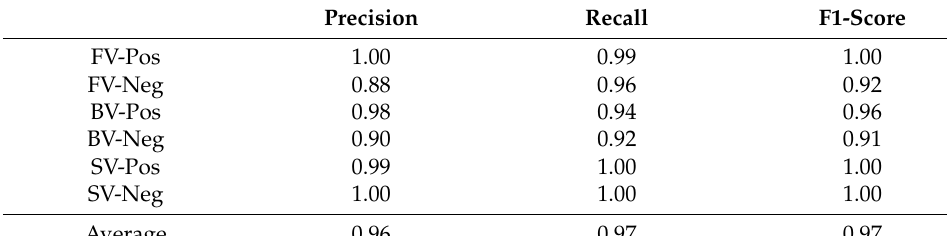
Table 11. The evaluation results of the first experiment on the PETA dataset.